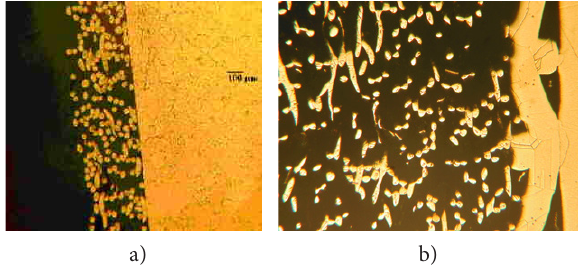
Figure 3. Porous structure with the base: a – fibrous;